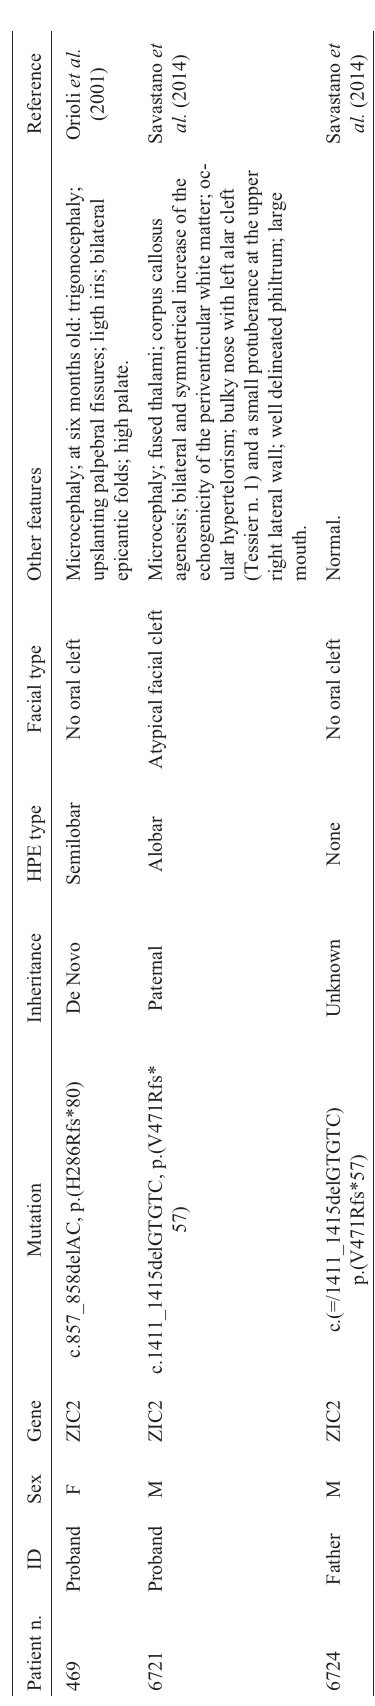
p.(C183F) with alobar HPE, microcephaly, ocular hypo-